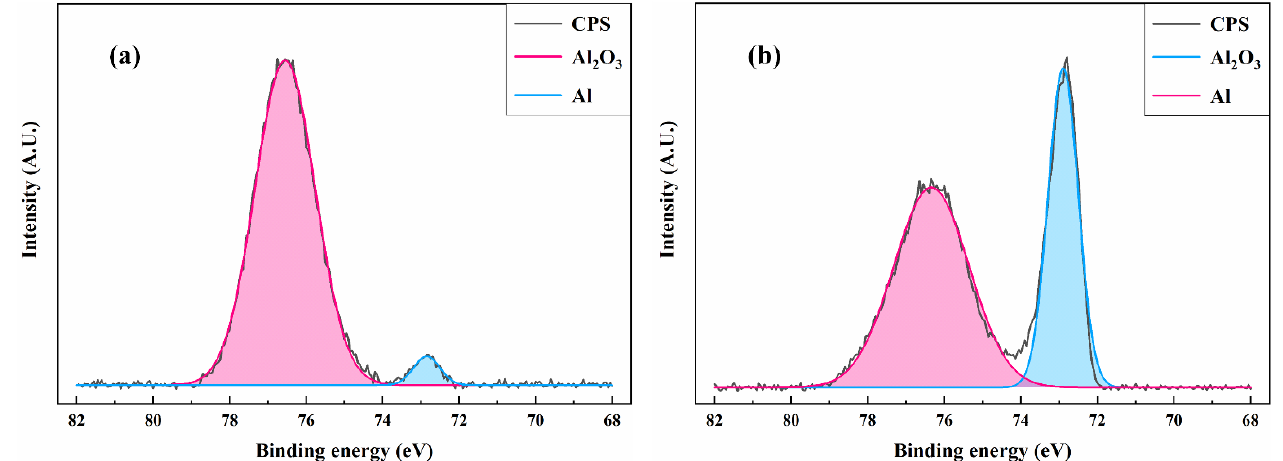
Figure 5. The XPS spectrum of Al 2p: ( a ) untreated; ( b ) laser cleaning.